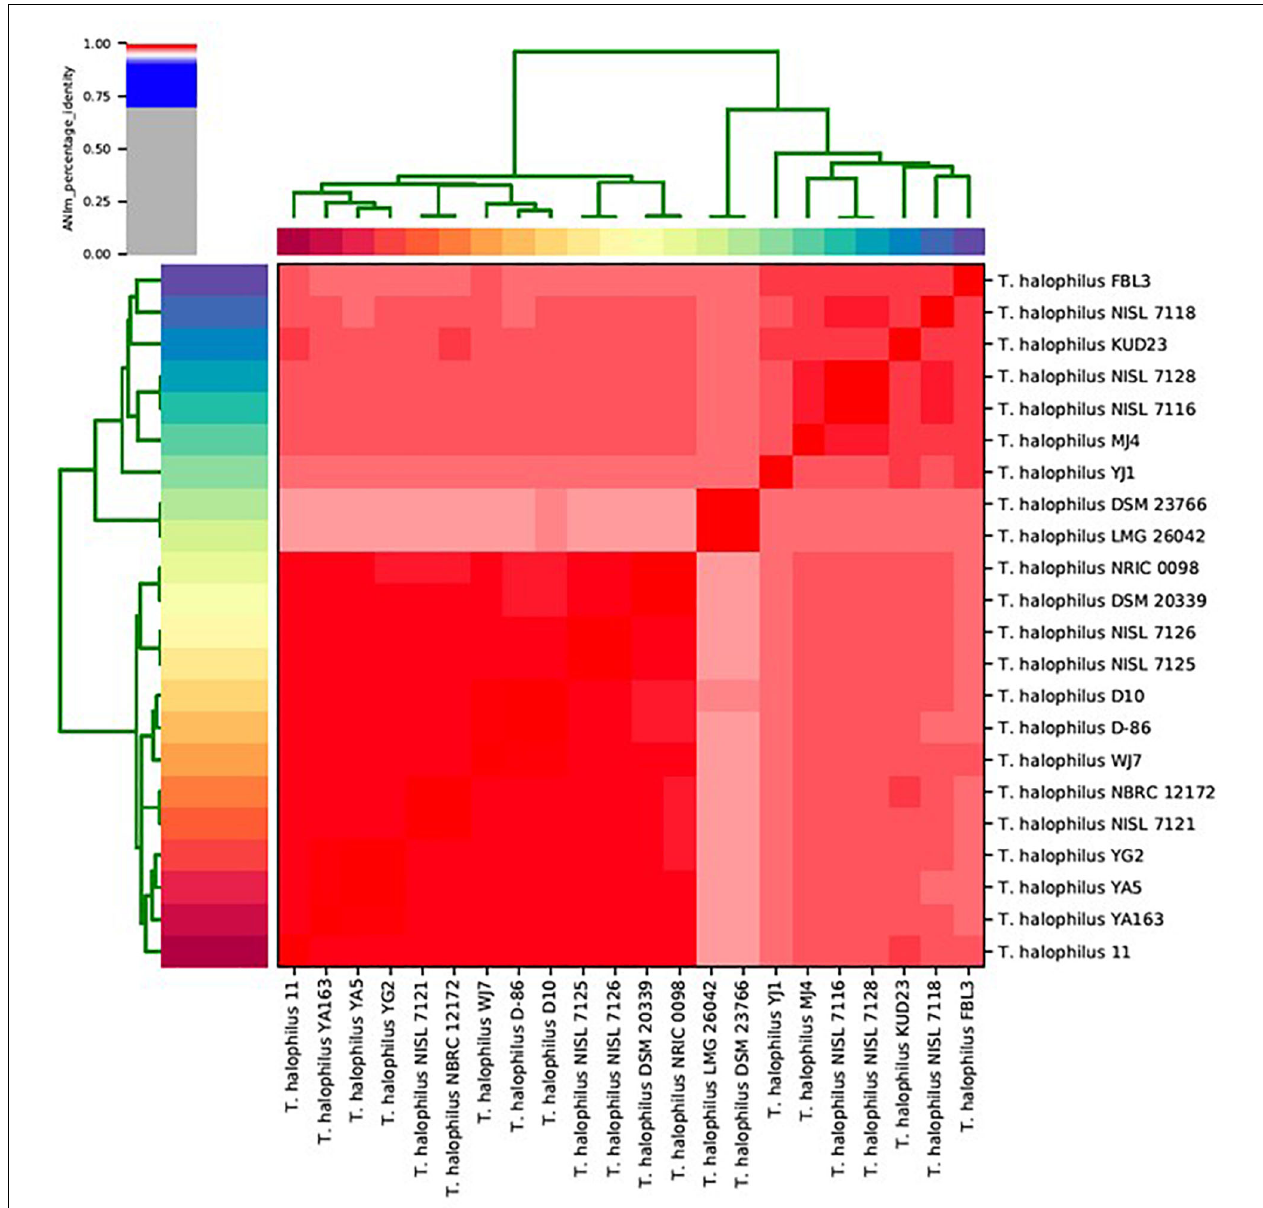
FIGURE 1 | Matrix and clustering of average nucleotide identity based on MUMmer (ANIm) identification of 22 Tetragenococcus strains. Red color in the heatmap indicate highly conserved genome pairs.